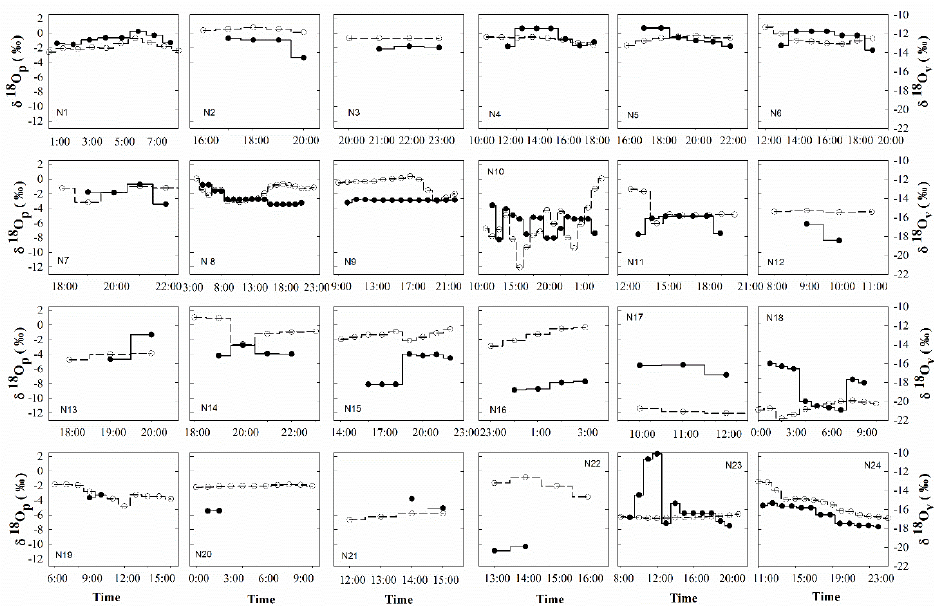
Figure 2. Variations in the isotopic composition of precipitation ( δ p , solid circles) and water vapor ( δ v , open circles) in 24 rain events.